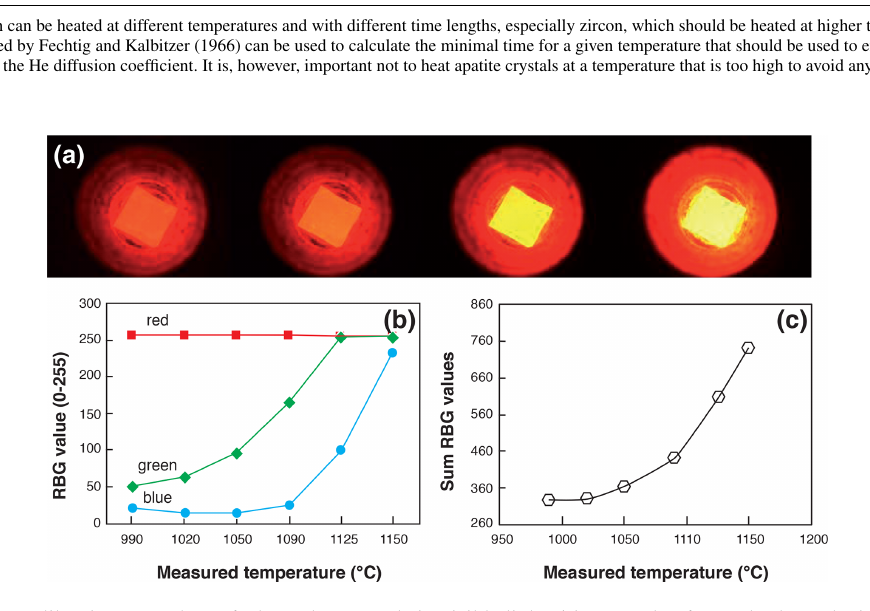
Figure 2. Temperature calibration procedure of a heated Pt capsule in visible light. (a) Example of capsules heated with different laser beam intensities showing the change in color. (b, c) Evolution, as a function of the temperature measured using a pyrometer, of the RBG code values and their sum,